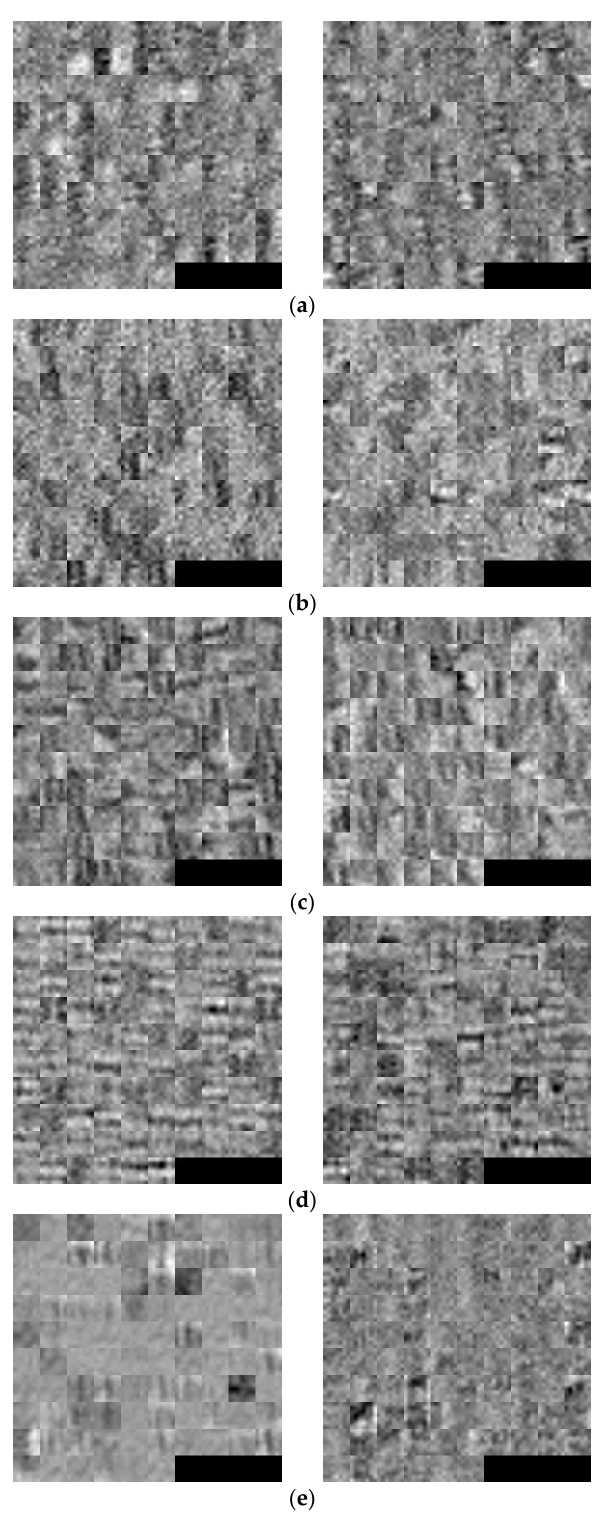
Figure 9. Visualization of filter weights in the first convolutional layers of the CNN model in each size class, in which the left and right images are from the training results on the first and second subsets for two-fold cross-validation, respectively: ( a ) 1st size class; ( b ) 2nd size class; ( c ) 3rd size class; ( d ) 4th size class ; and ( e ) 5th size class.